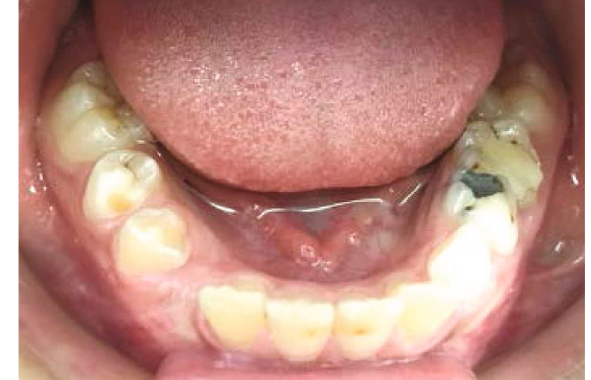
Figure 10: Intraoral view showing complete eruption of tooth 44 after 12 months